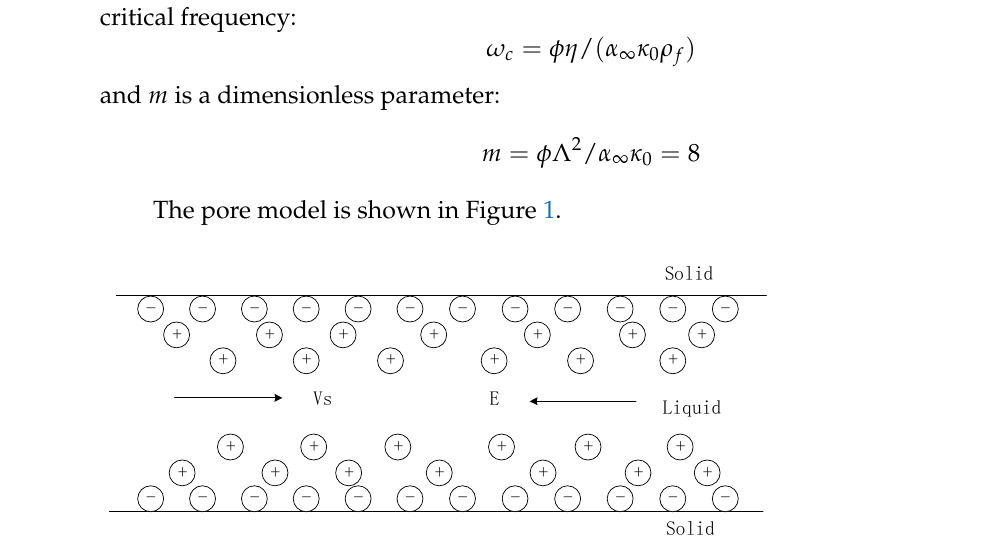
Figure 1. Pore model.